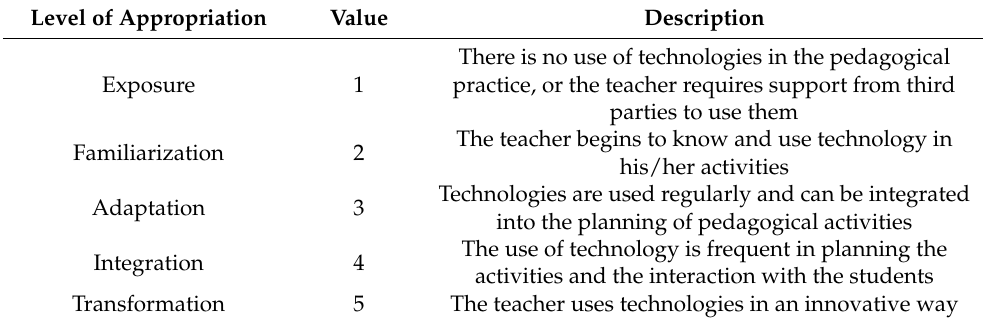
Table 3. Levels of appropriation.